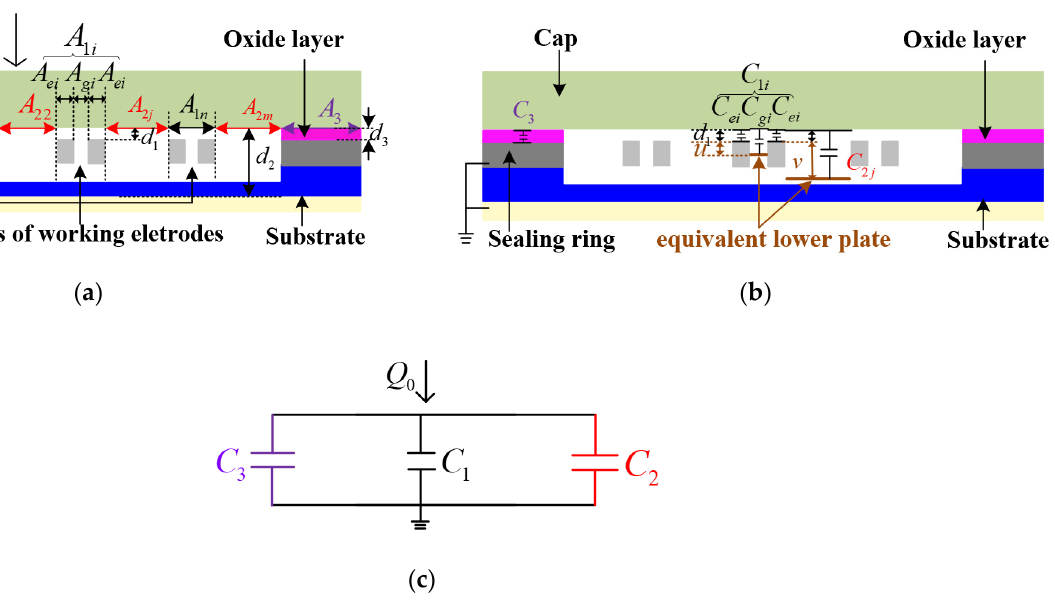
Figure 3. ( a ) Packaging structure model; ( b ) structural capacitors in the packaging structure model; ( c ) capacitance model.